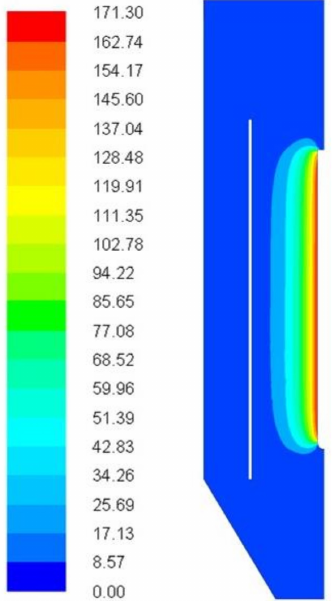
Figure 5. Local values of ultraviolet radiation dose calculated in the whole reaction zone of photoreactor (w / m 2 ).